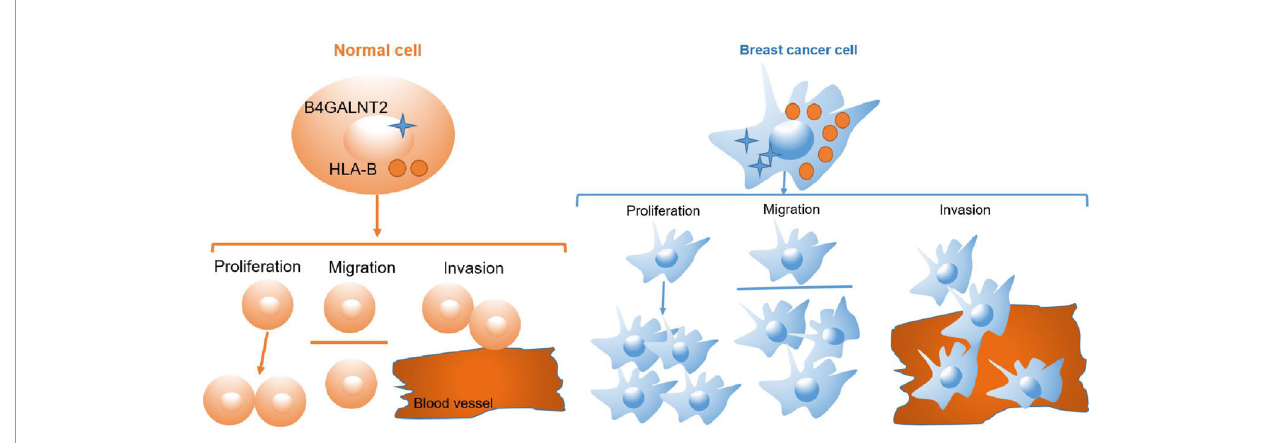
FIGURE 8 | Cell pattern diagram of B4GALNT2 interacting with HLA-B protein to promote breast cancer cell proliferation, migration and